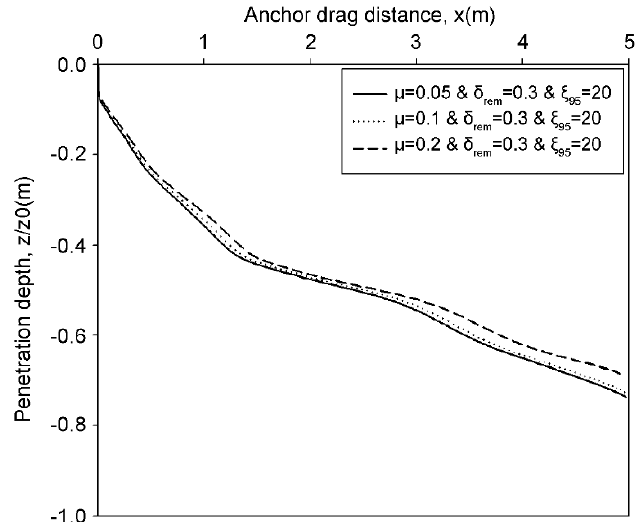
Figure 18. Effects of strain rate on anchor penetration depth.